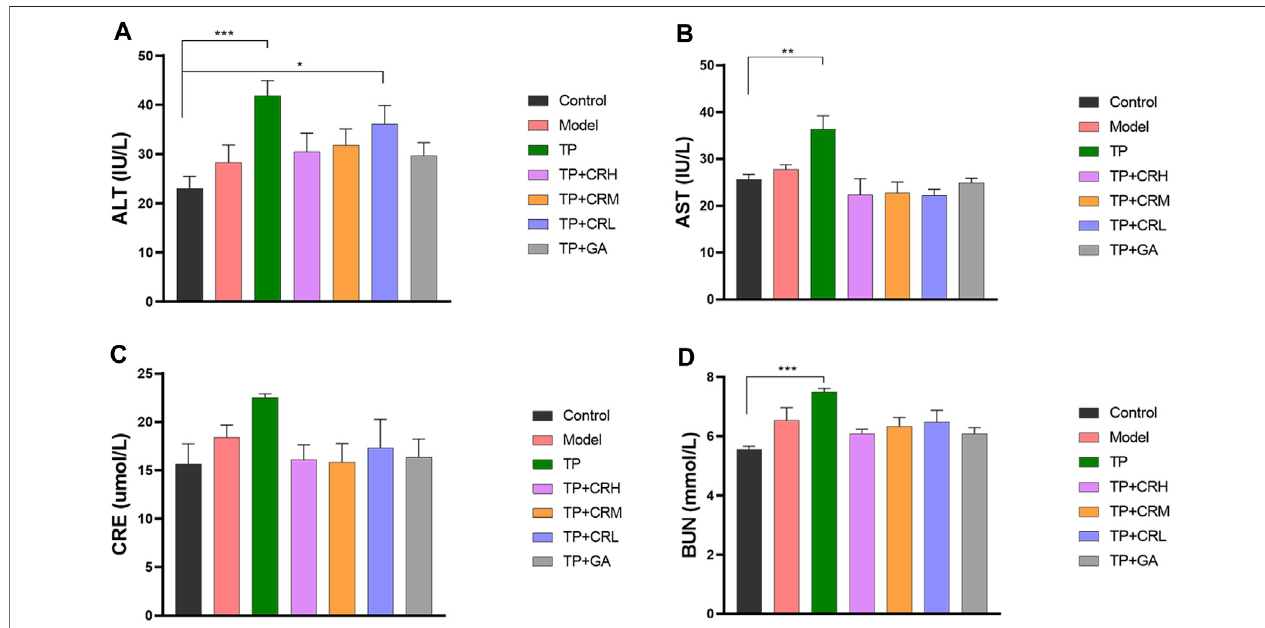
FIGURE3| ThelevelsofALT (A) ,AST (B) ,CRE (C) ,BUN (D) intheCIAmiceliverweredeterminedusingrespectivekits,after20 daysofdifferenttreatment.(n=8) ** p < 0.01,*** p < 0.001vs.Control.ALT,alaninetransaminase;AST,aspartatetransaminase;CRE,creatinine;BUN,bloodureanitrogen;CIA,collagen-inducedarthritis.